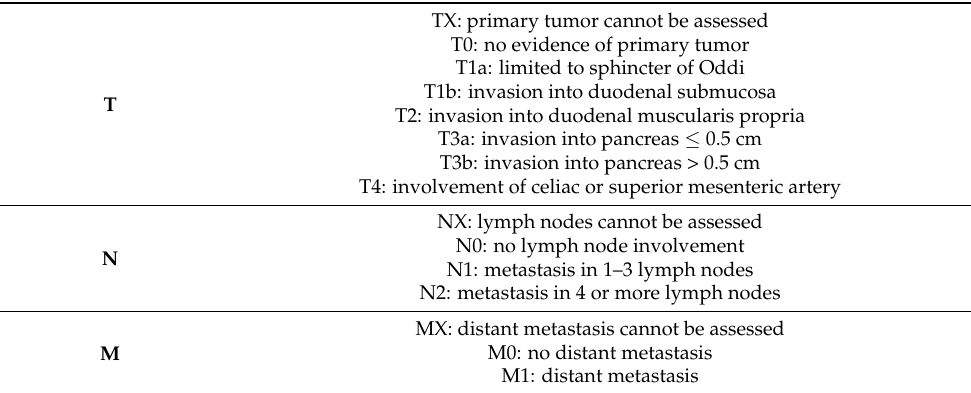
Table 2. The 8th edition of the TNM staging system by the Union for International Cancer Control